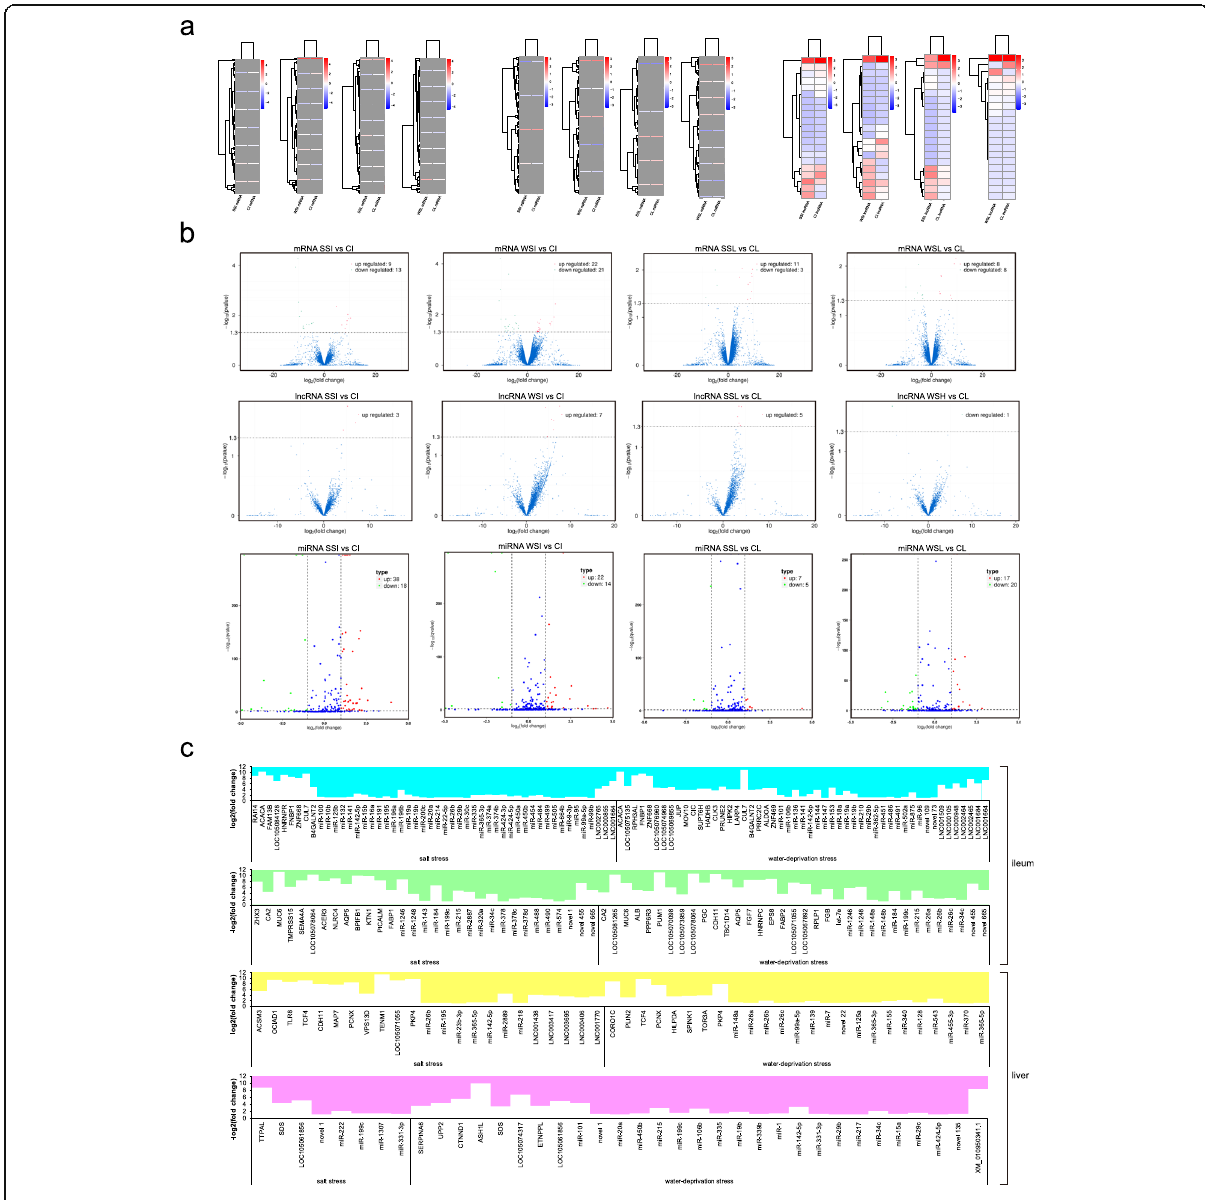
Fig. 2 Differential mRNAs, miRNAs and lncRNAs in ileum and liver under salt stress and water-deprivation stress. a Expressed level of mRNA and lncRNA with value of log10(FPKM+ 1), and miRNA with value of log10(TPM + 1). b Number of differential mRNAs, miRNAs and lncRNAs. c Log2(fold change) values of up-regulated mRNAs, miRNAs and lncRNAs and -log2(fold change) values of down-regulated mRNAs, miRNAs and lncRNAs. SSI, WSI, CI, SSL, WSL and CL separately indicate ileum under salt stress, ileum under water-deprivation stress, control ileum, liver under salt stress, liver under water-deprivation stress and control